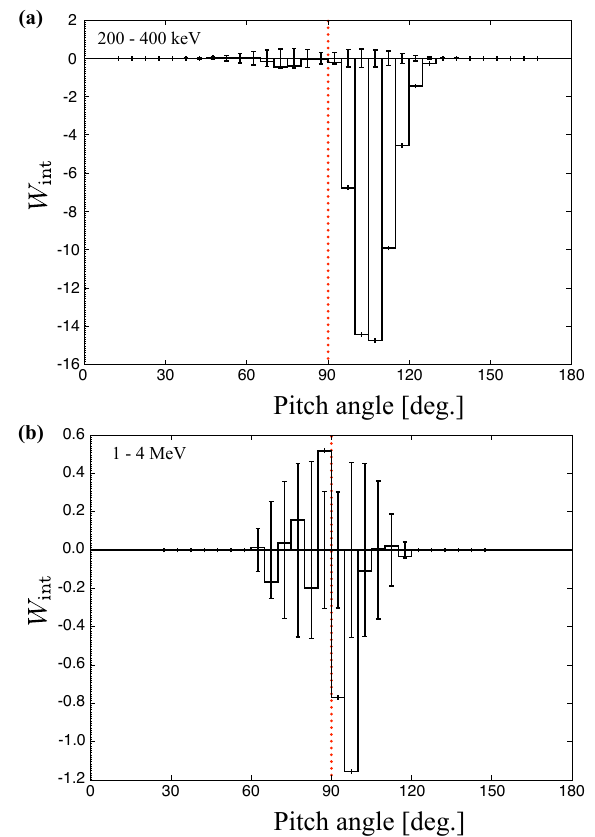
Fig. 6. W int computed (a) in the energy range from 200 to 400keV and (b) from 1 to 4MeV for the time interval from 0 to 20000 (cid:127) − 1 in pitch angle intervals of 5 degrees. The computed 1.96 σ W of each pitch angle bin is also